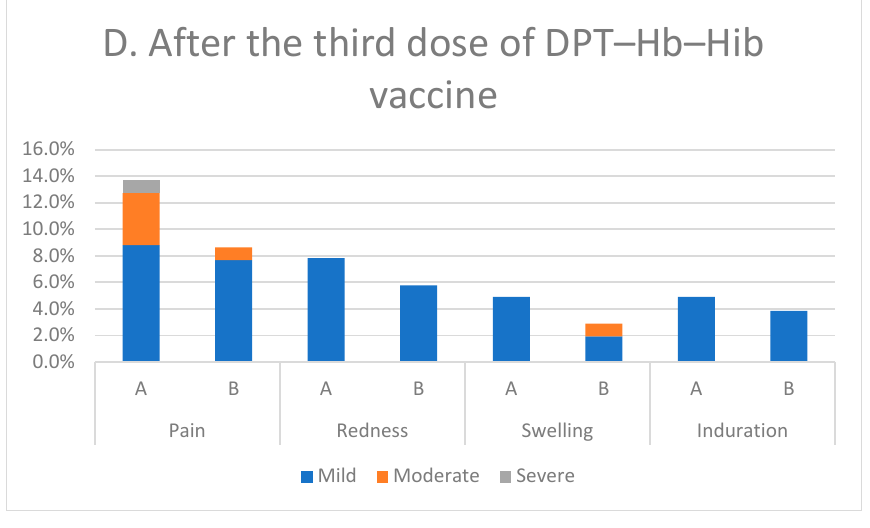
Vaccines 2023 , 11 , x FOR PEER REVIEW